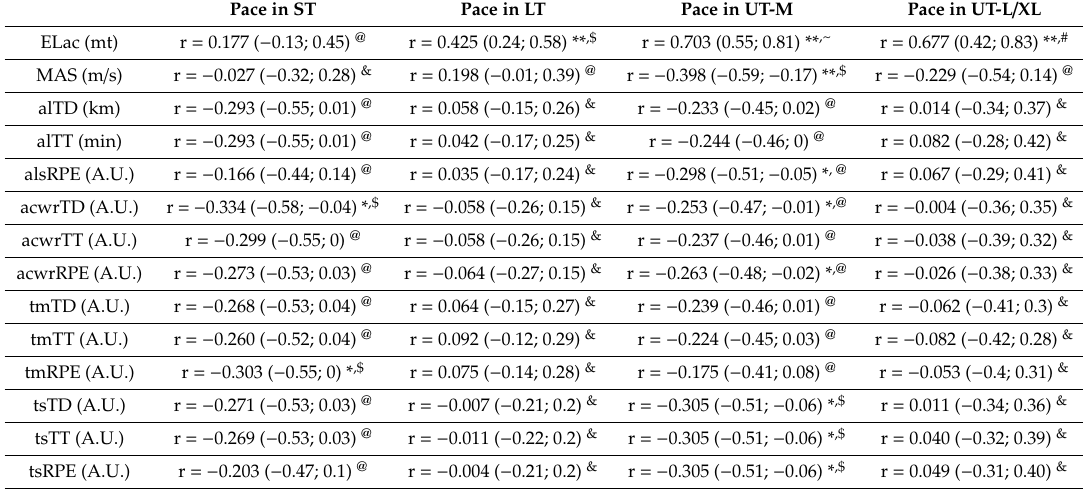
Table 6. Correlation coe ffi cients between pace and physical fitness and workload indices. Pace in ST Pace in LT Pace in UT-M Pace in UT-L /